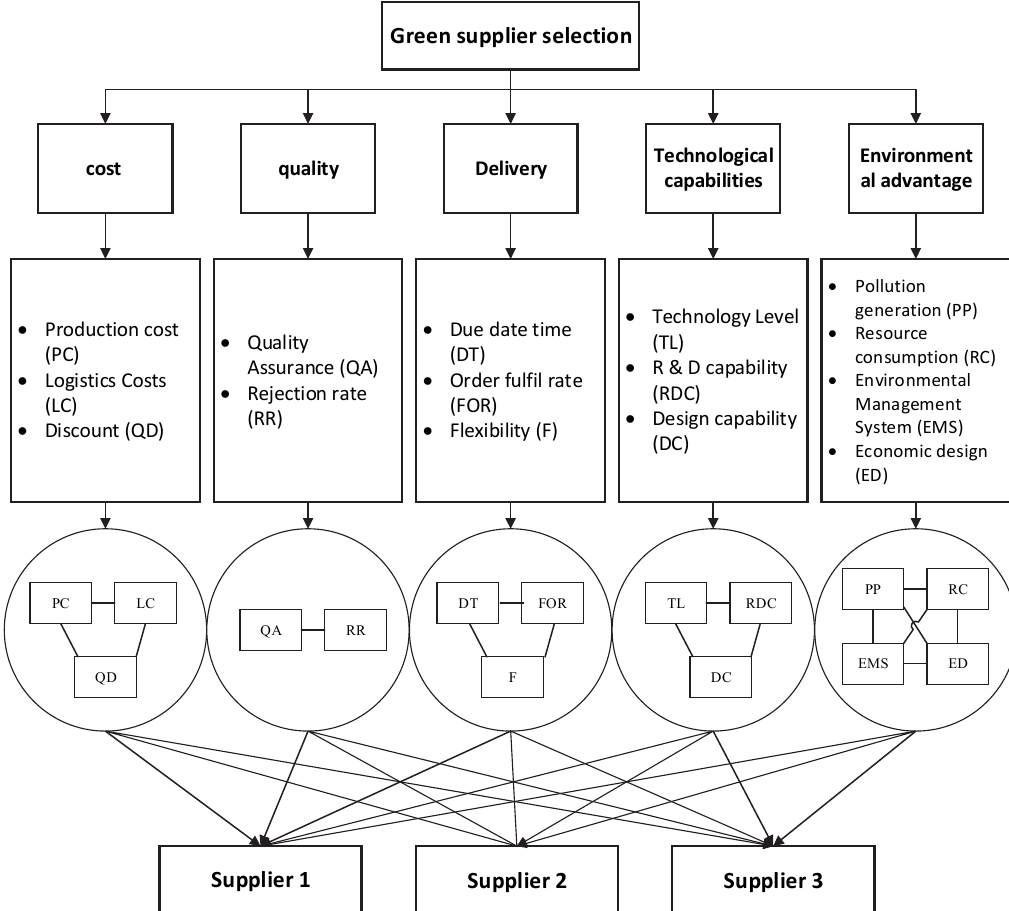
Fig. 2. The ANP model of supplier selection for the green supply